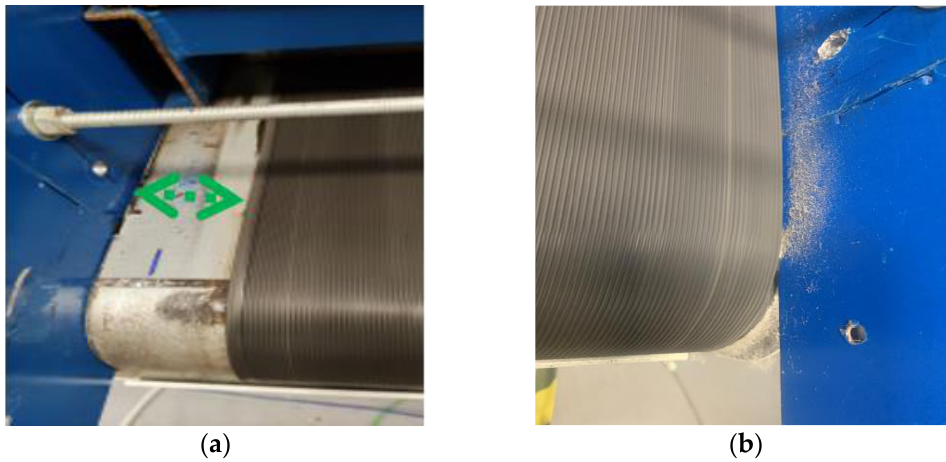
Figure 3. ( a ) The normal belt tracking: no contact between the belt and the metal wall; ( b ) a belt mis-tracking: the belt and the metal wall are in contact.